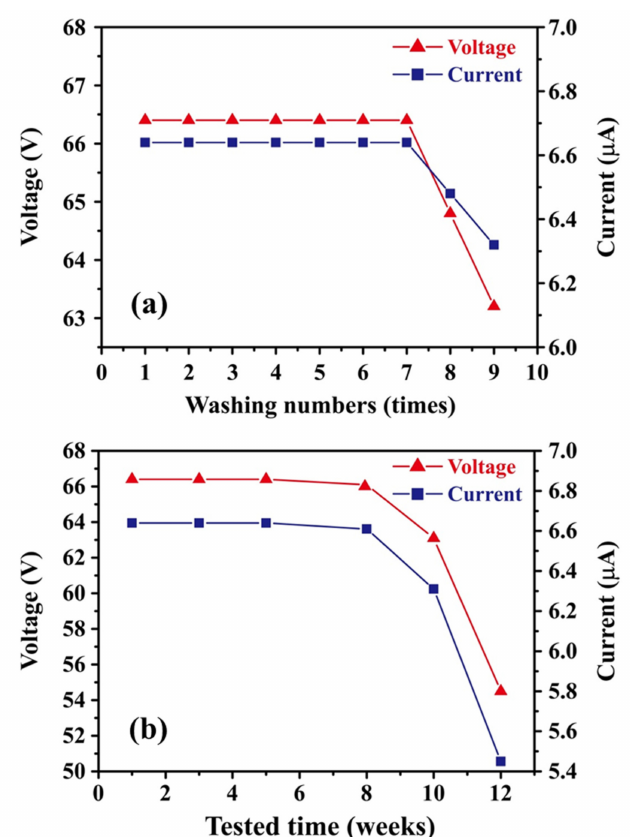
Figure 8. Washability and durability test results for TEG device: ( a ) output voltage and current following repeated wash cycles, and ( b ) output voltage and current in daily tests performed over 12-week period. The TEGs connected to an external load with a resistor of 10 M Ω